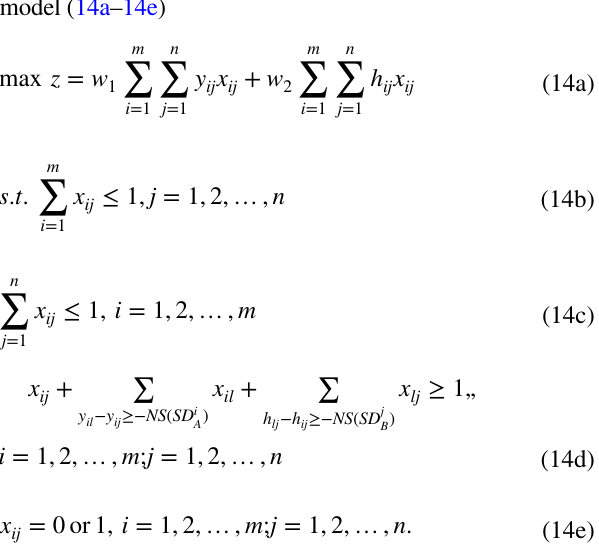
Table 1 Incomplete weak preference ordering information provided by the individuals in the A matching party and B matching party